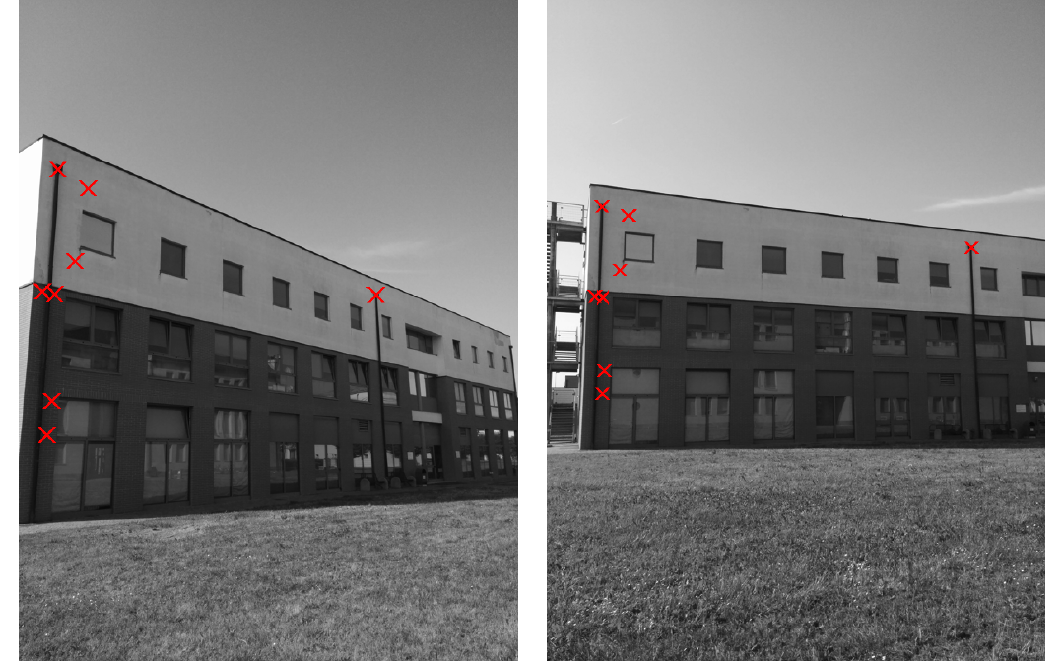
Figure 4. Example of feature points correctly matched by means of the SIFT descriptors.